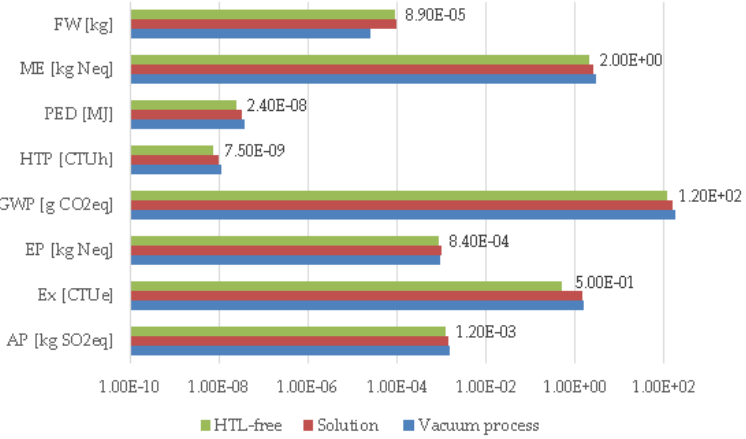
Figure 1. Environmental impacts of manufacturing processes (logarithmic scale 100) [63].